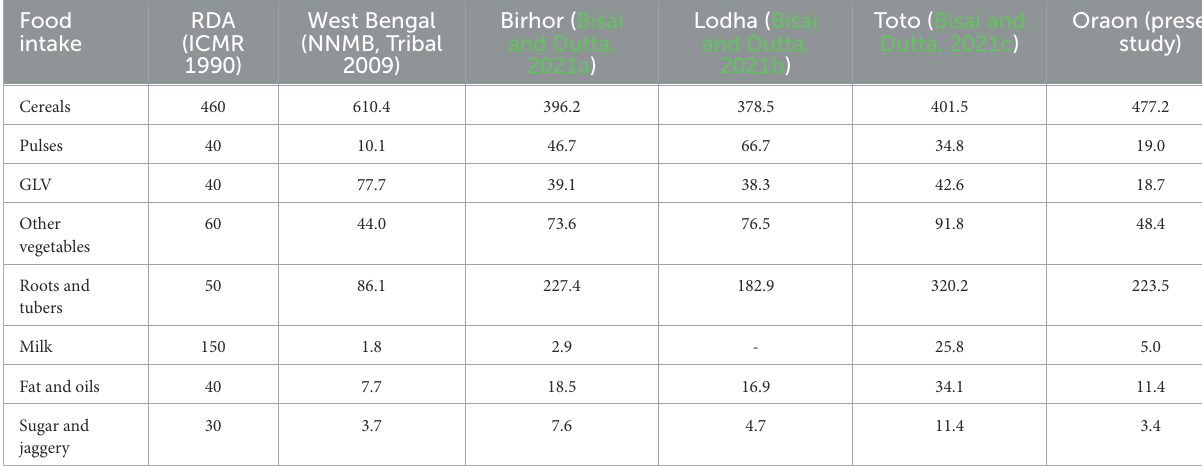
TABLE 5 Average nutrient consumption (pc/day) of Oraons of West Bengal. Nutrient